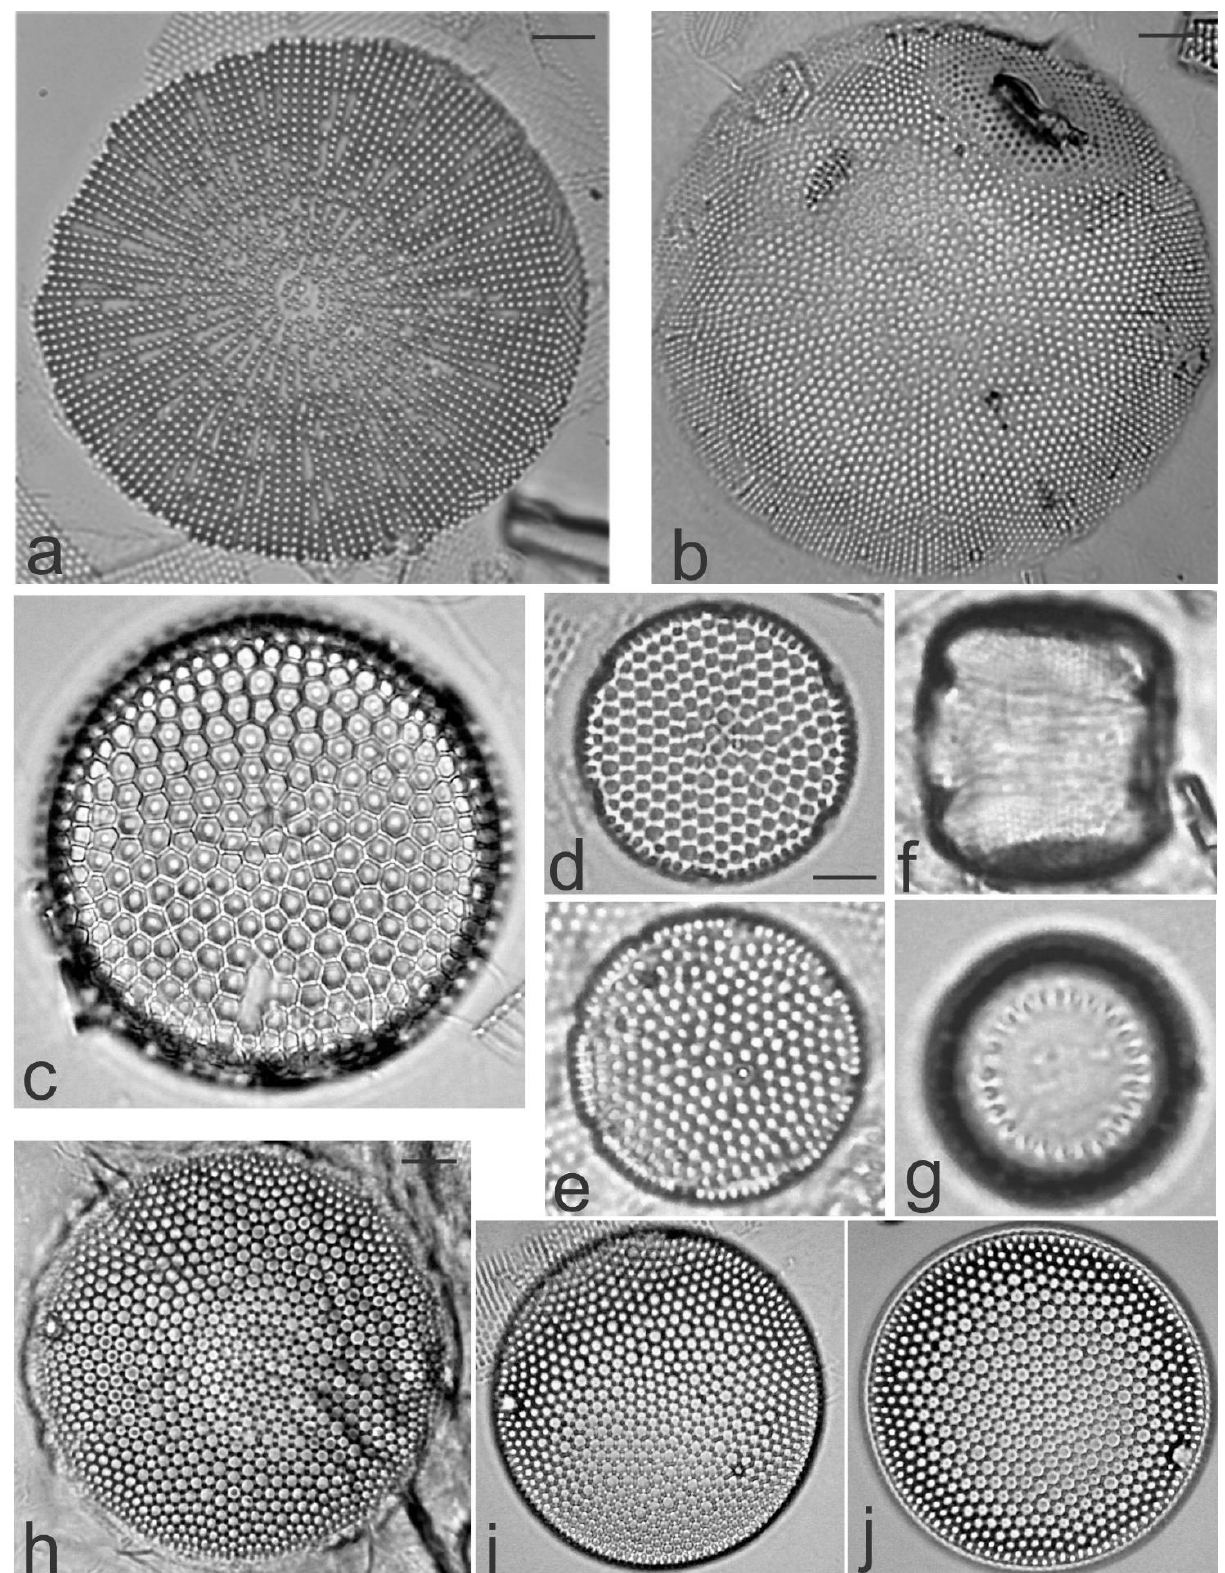
Figure 4. ( a ) Actinocyclus octonarius var. ralfsii ; ( b ) Actinocyclus octonarius ; ( c ) Azpeitia nodulifera ; ( d , e ) Azpeitia neocrenulata ; ( f ) Hyalodiscus scoticus ; ( g ) Paralia sulcata ; ( h – j ) Roperia tesselata . Scale bars = 10 μm.